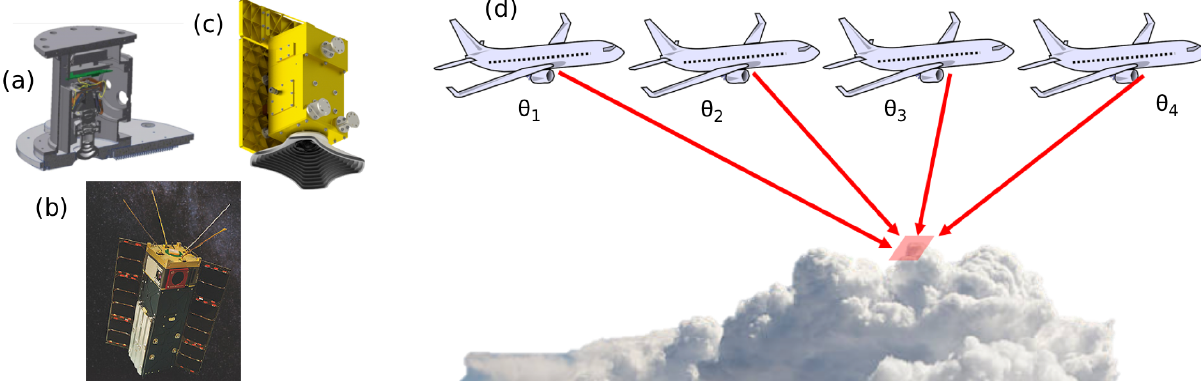
Figure 2. Panels (a) , (b) , and (c) illustrate the current HARP VNIR polarimeter family consisting of the AirHARP airborne system (a) , HARP CubeSat (b) , and HARP2 for the NASA PACE mission (c) . The HARP concept comprises a wide-field-of-view imaging polarimeter that images the same ground target from up to 60 distinct viewing angles at 0.67µm (d) and up to 20 viewing angles at 440, 550, and 870nm. The wide cross-track swath (94 ◦ ) of HARP2 allows for global coverage from space within